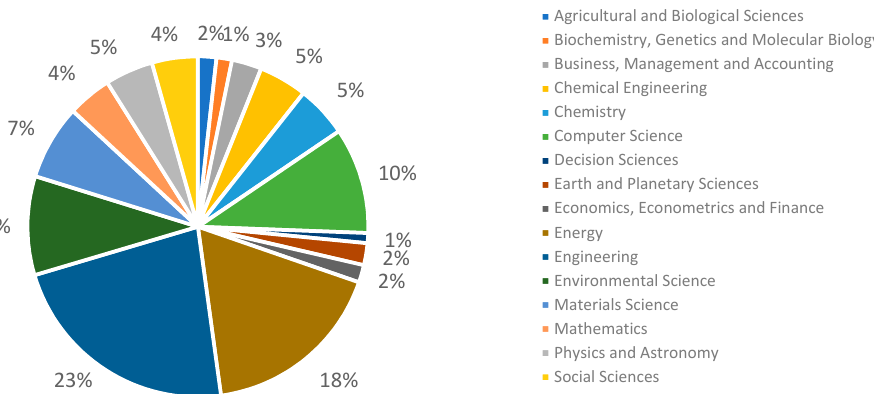
Figure 4. The main subject areas studying green electricity production technology (source: developed by the author based on Scopus and VOSviewer).